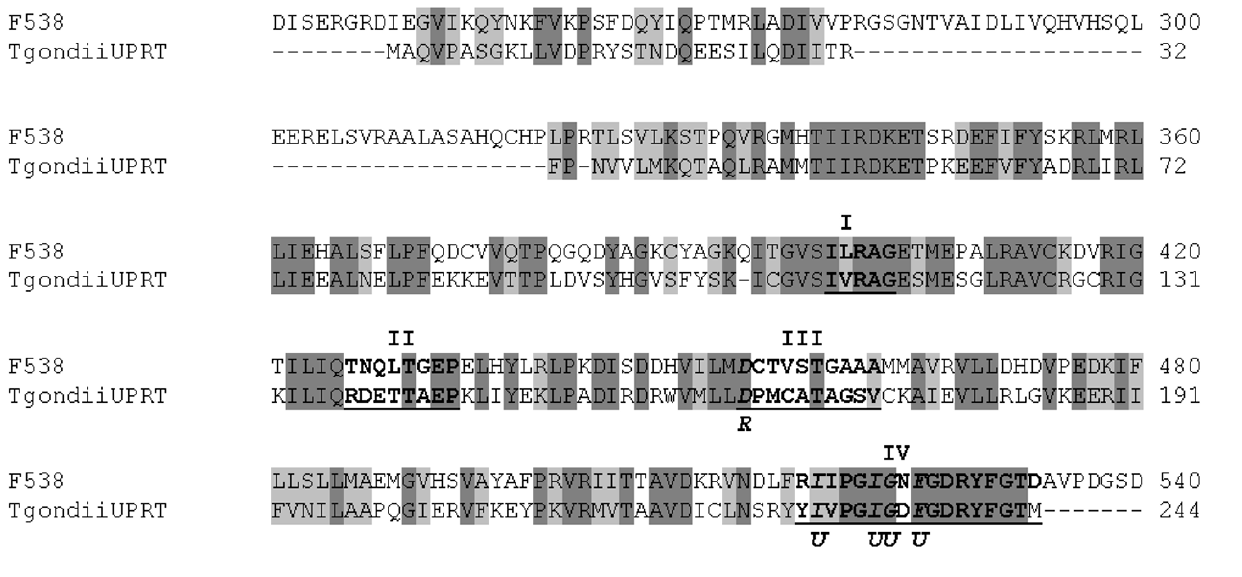
Figure 8 Protein sequence alignment of F538 and UPRT of Toxoplasma gondii. The four conserved regions are underlined. R – ribose binding residue, U – uracil binding residues.